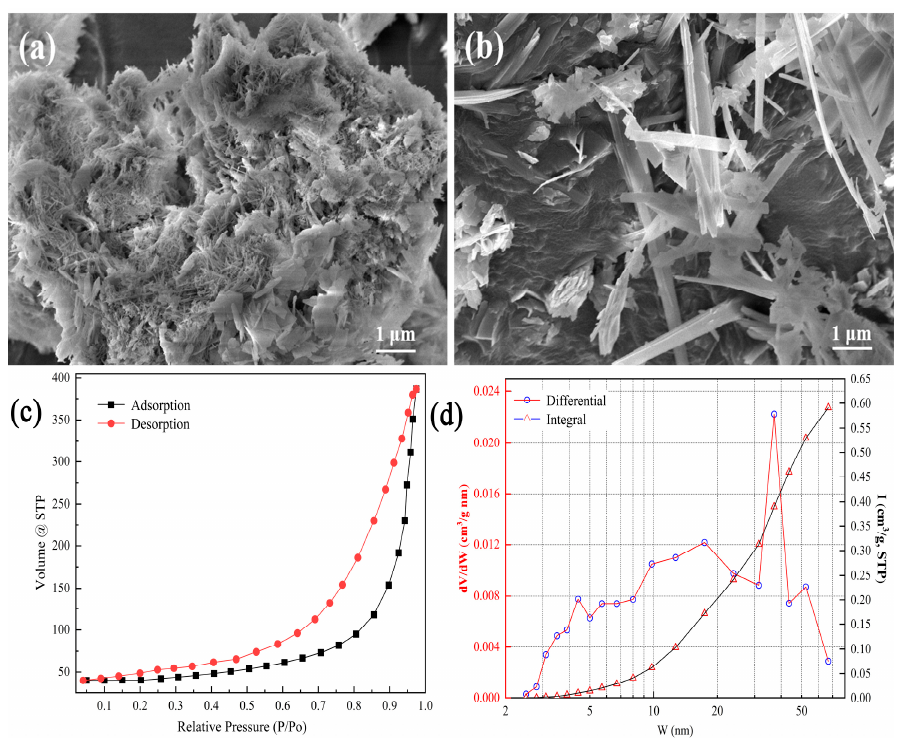
Figure 2. ( a , b ) SEM images, ( c ) nitrogen adsorption–desorption isotherms and ( d ) pore size distribution of tobermorite.